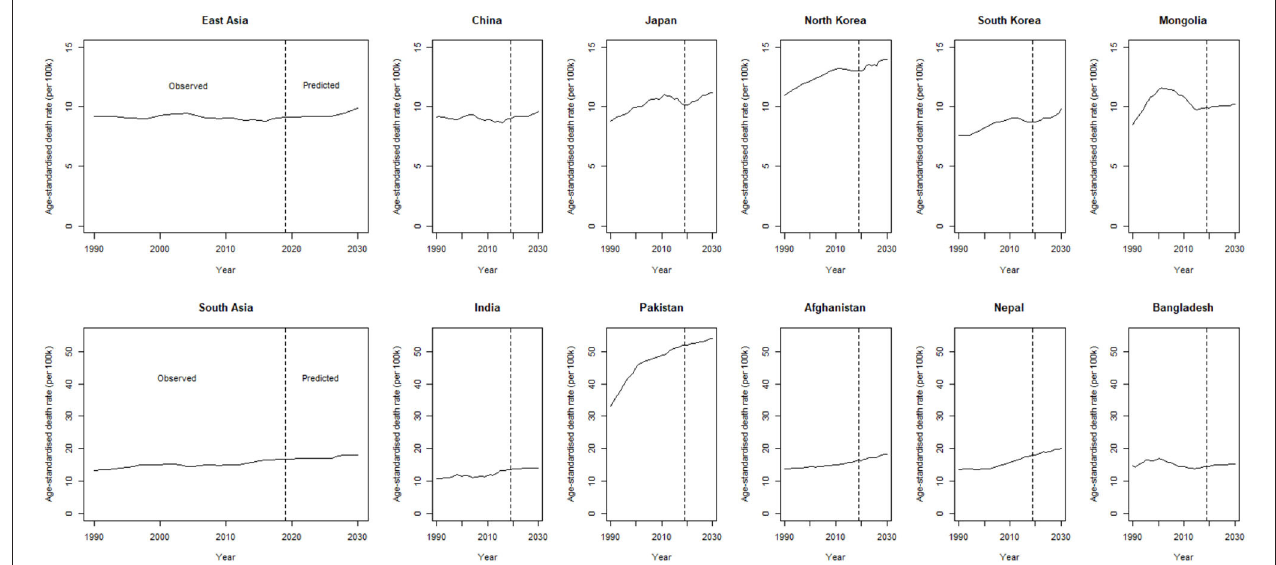
The results of estimation of parameters in the LC model, for twelve locations (2 regions and 10 countries) are described in Supplementary Figure 2 . The estimated values of age-dependent parameters α x and β x , and the time-dependent parameter k t are